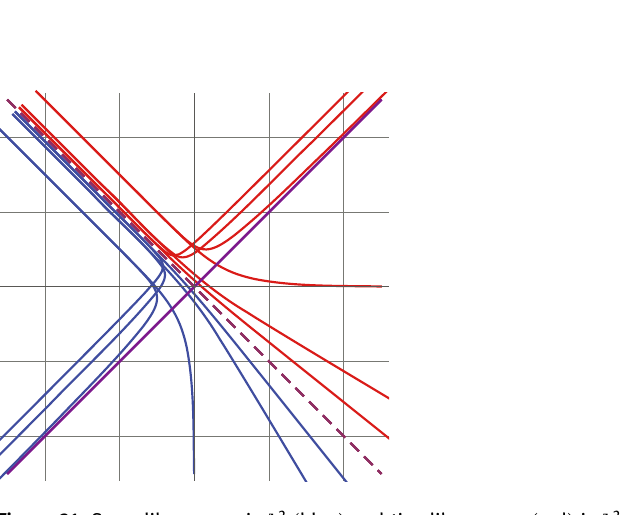
Figure 21: Spacelike curves in (cid:2) 2 ( blue ) and timelike curves ( red ) in (cid:2) 2 with (cid:2) ( ) =